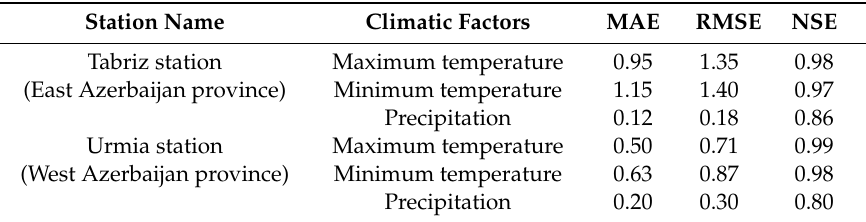
Table 2. Results of SDSM performance for the observed and simulated data in the validation period